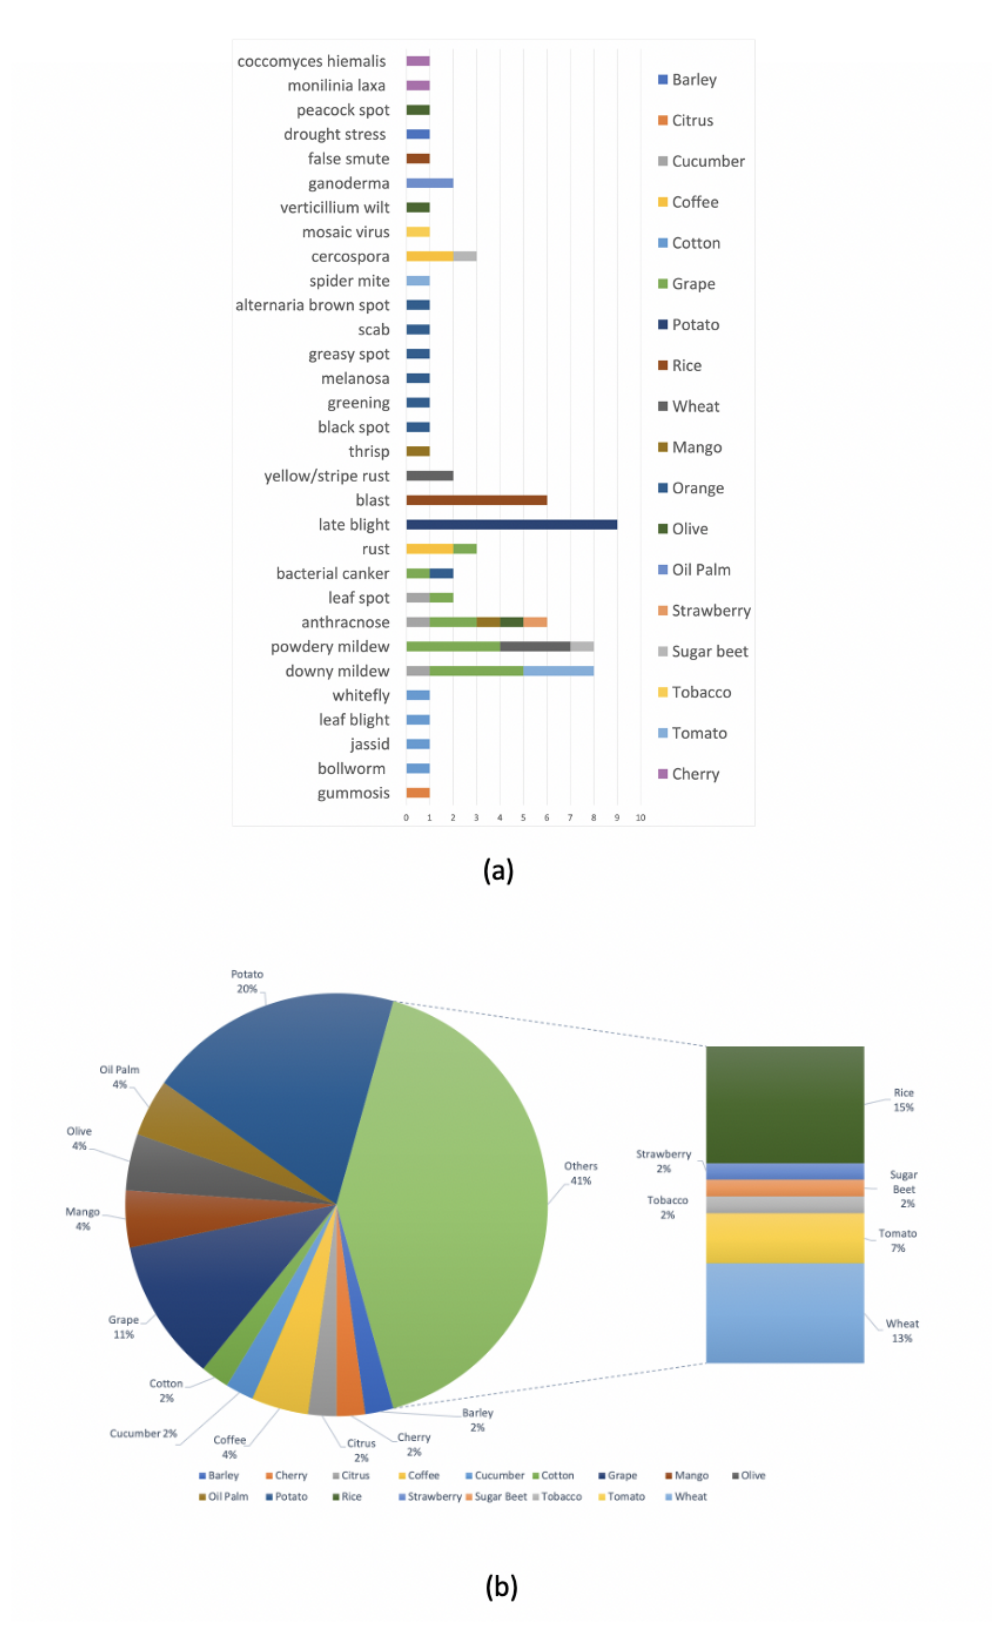
Figure 4. ( a ) Number of publications based on crop and disease examined; ( b ) current state of crops and plants explored during the last 10 years in terms of percentage of research